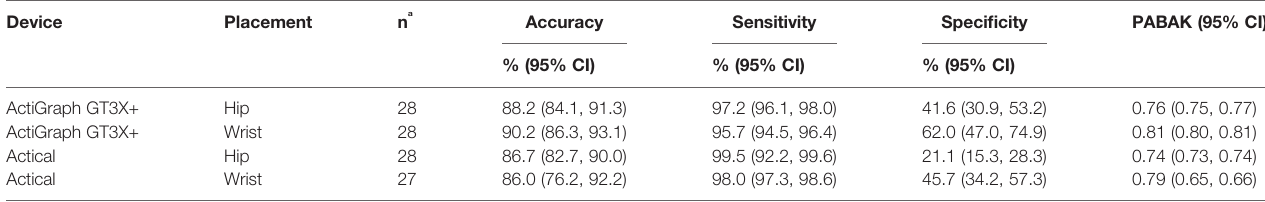
TABLE 2 | Sensitivity, speci fi city, and accuracy of epoch-by-epoch comparisons with PSG of the two accelerometers placed at the hip and the wrist. Device Placement n